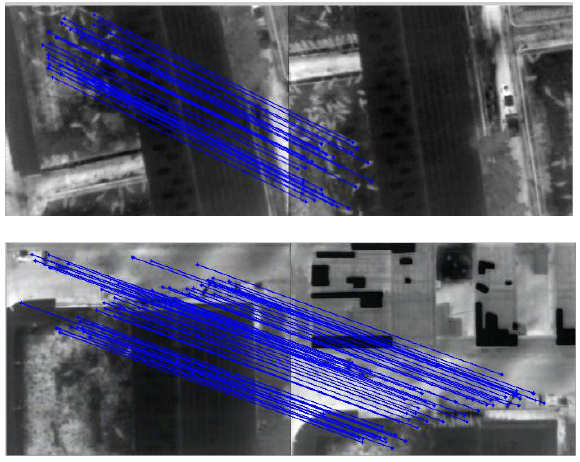
Figure 4. Tie points